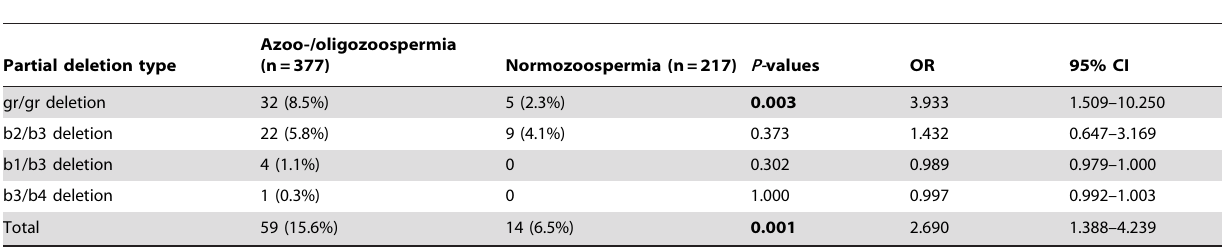
Table 1. The distribution of partial AZFc deletion in groups with different spermatogenic status.